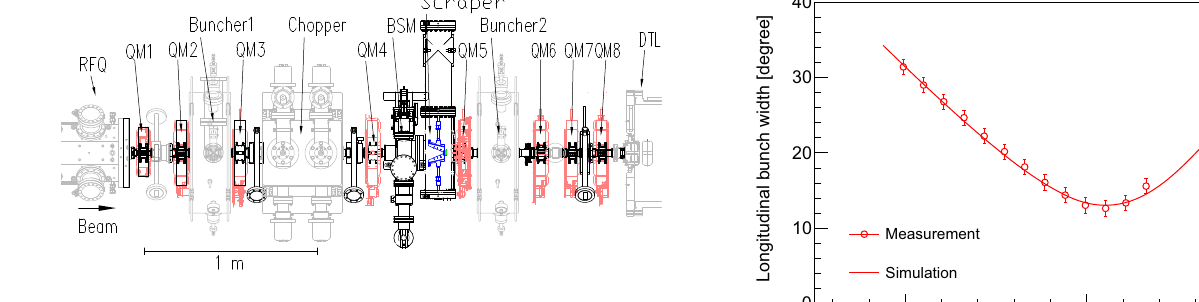
FIG. 14. Schematic of MEBT1 in the J-PARC linac. QM means a quadrupole magnet. There are eight QMs, two bunchers, a set of beam chopper and scraper, and one BSM in the MEBT1.